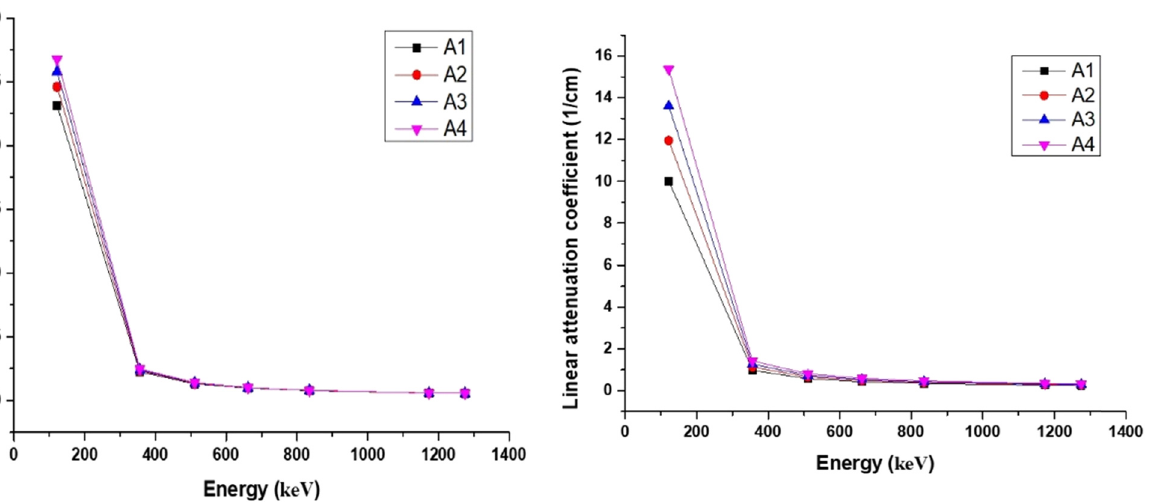
e ff ects on humans or the environment. The MAC of the four glasses between 122 and 1,275 keV is depicted in Figure 3. The MACs are relatively higher at low energies.